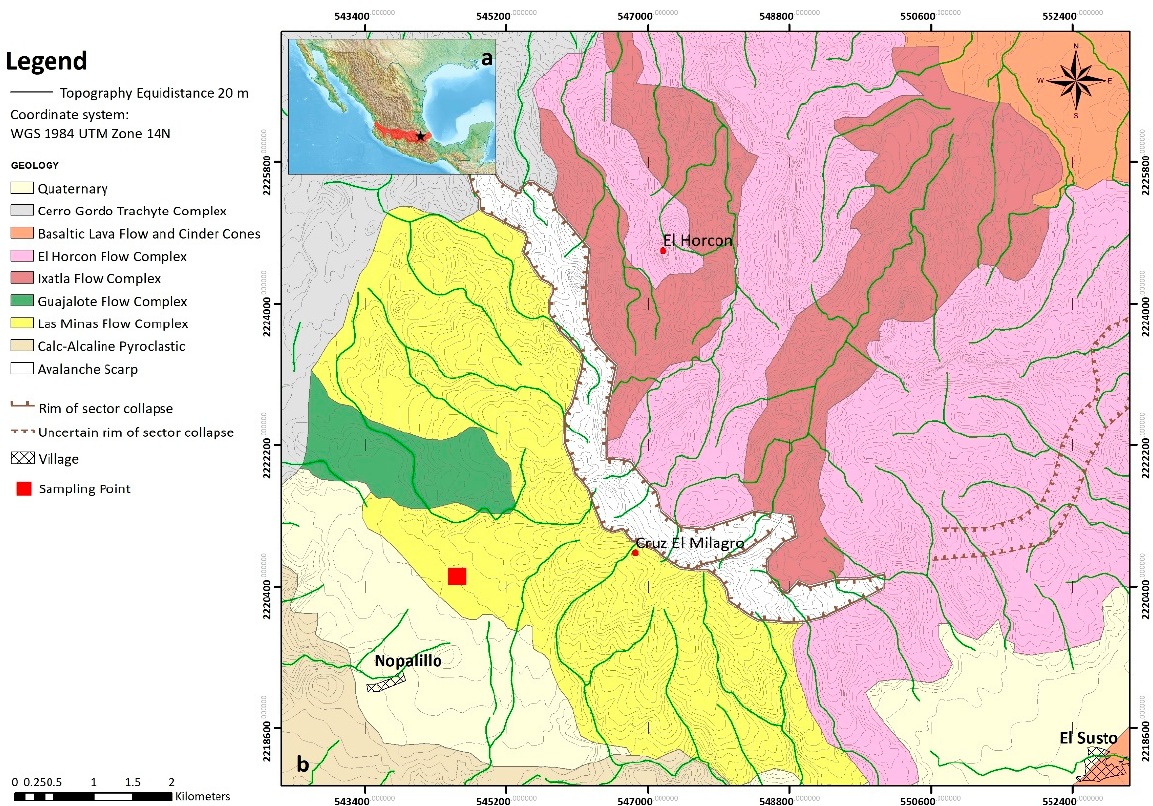
Figure 1. ( a ) The trans-Mexican volcanic belt (File: Eje Neovolcánico Mexico.jpg-Wikimedia Com- mons, author: Soleincitta, file licensed under the Creative Commons Attribution-Share Alike 3.0 Unported license). The star indicates the position of Sierra de las Navajas volcano. ( b ) Geological map of the area of Sierra de Las Navajas. Redrawn on the basis of the map of [9]. Topographic background obtained by shapefiles provided by INEGI of Pachuca (Hidalgo). The red square indi- cates the sampling point.